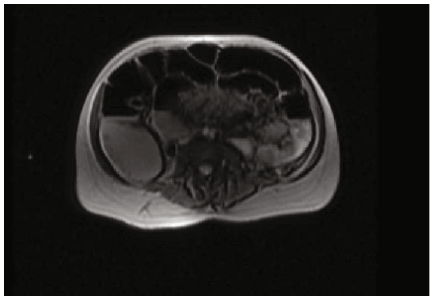
Figure 1: Magnetic Resonance